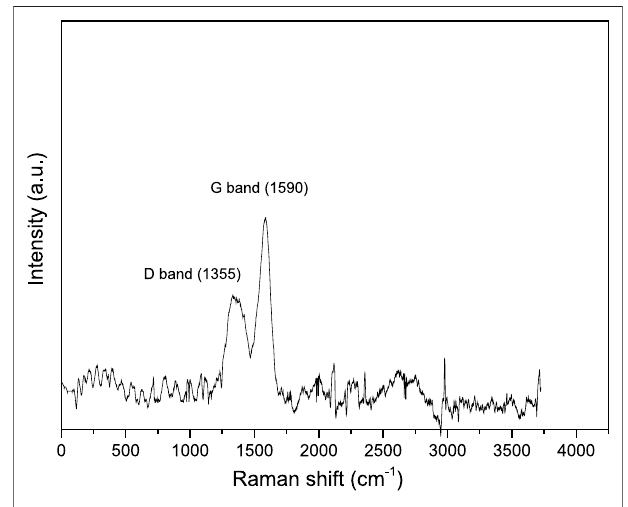
FIGURE 10 | Raman spectra of the GOWE-0.1 coating.